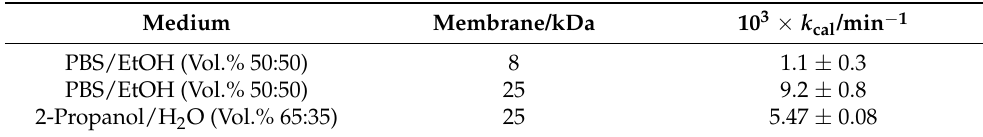
Table 3. Rate constants in calibration